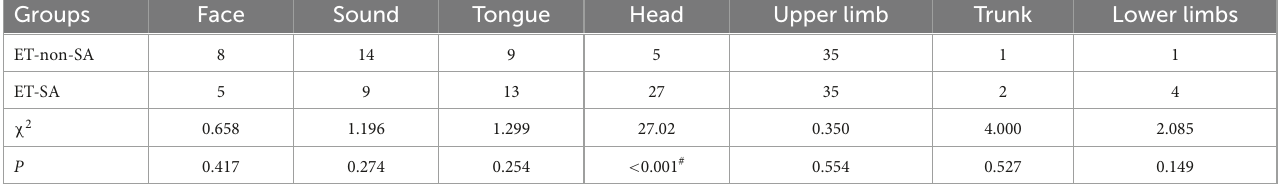
TABLE 5 Multivariable analysis of disease risk factors for essential tremor patients with social anxiety (ET-SA). X B Sb Lower Upper Sex (female vs.